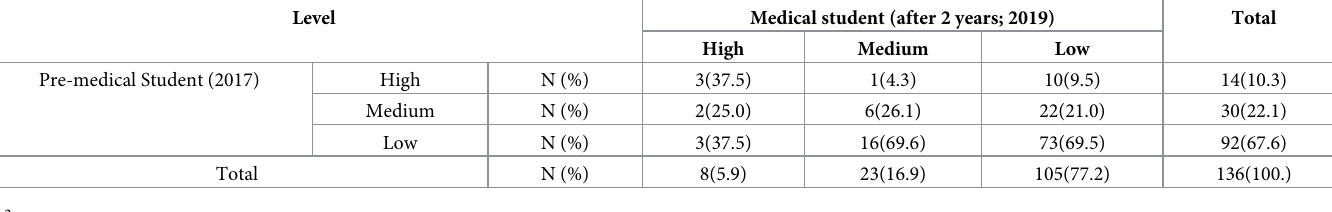
Table 3. Changes in reflective thinking